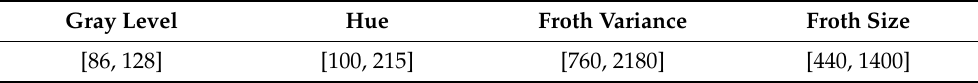
Table 5. Optimal intervals of froth image features. Gray